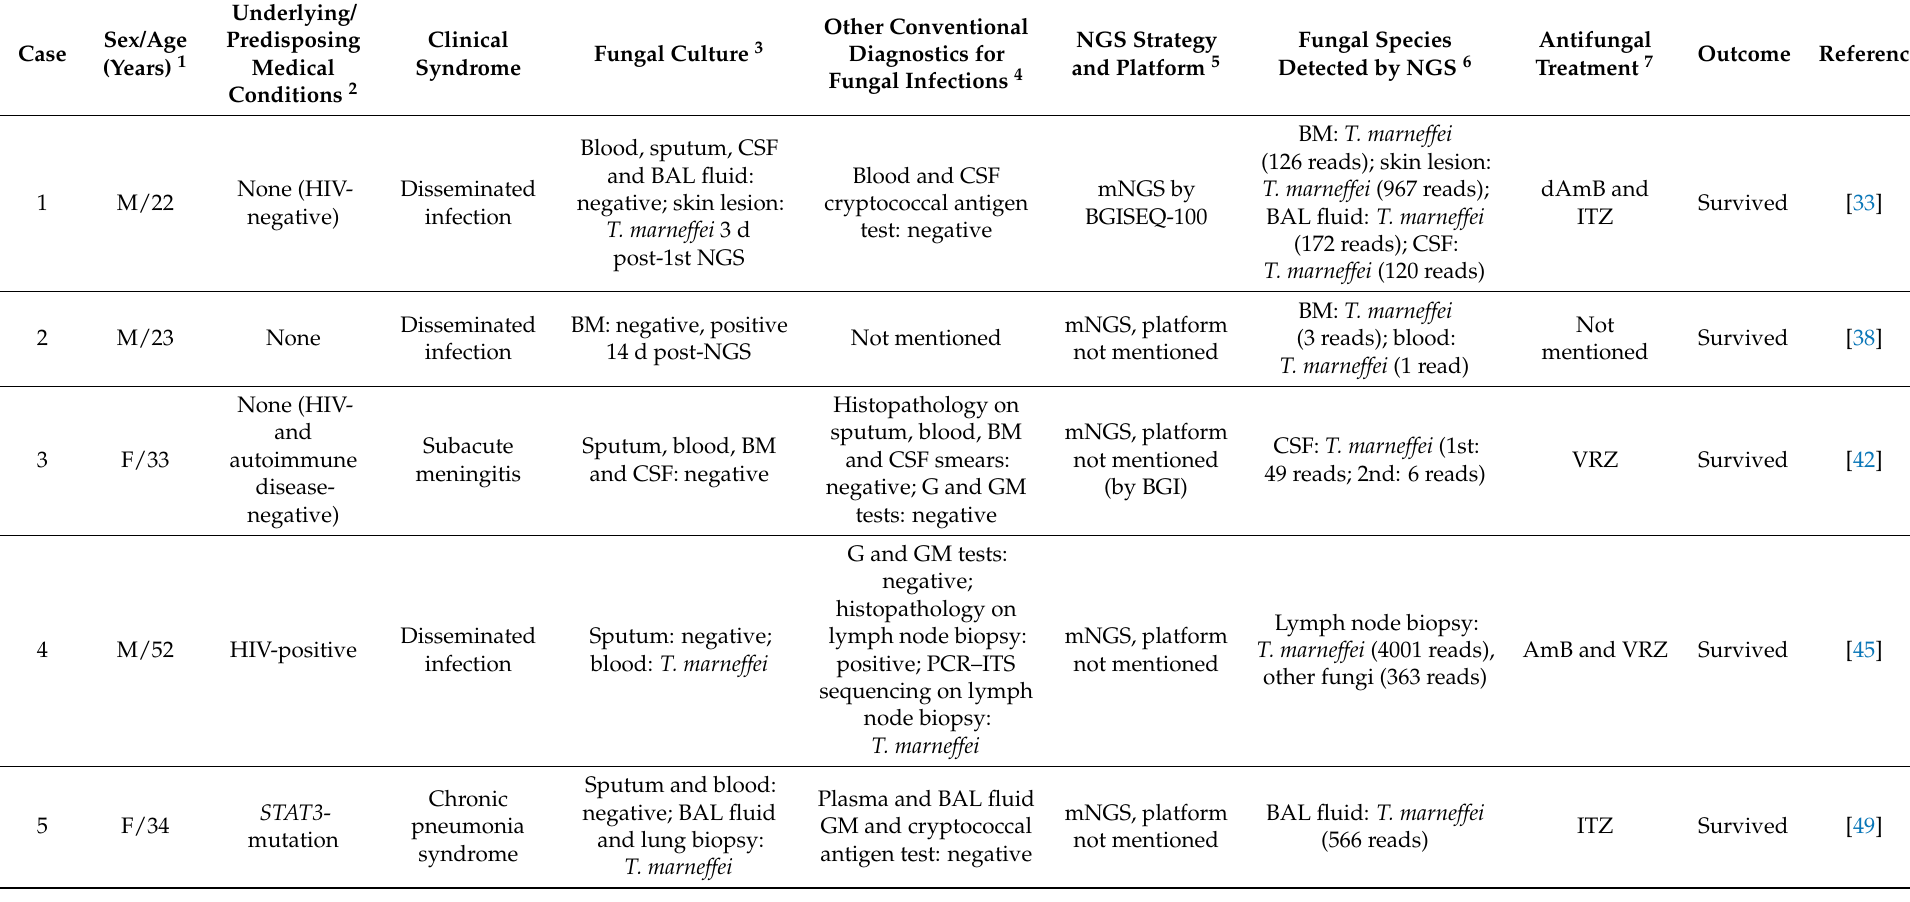
Table 1. Reported cases of talaromycosis diagnosed with the aid of next-generation